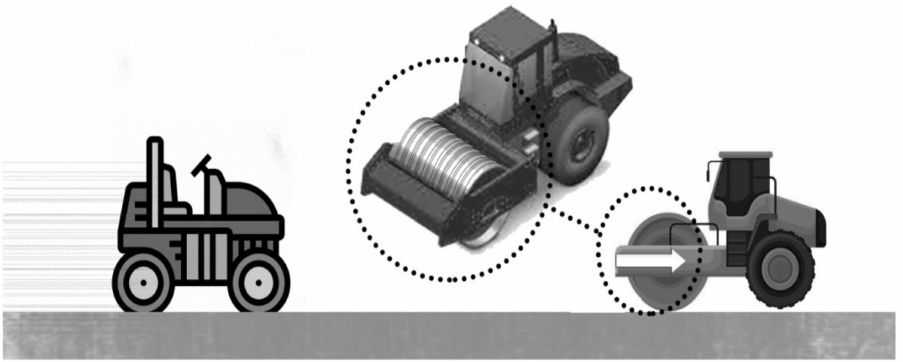
Figure 2. Steps of the stamping